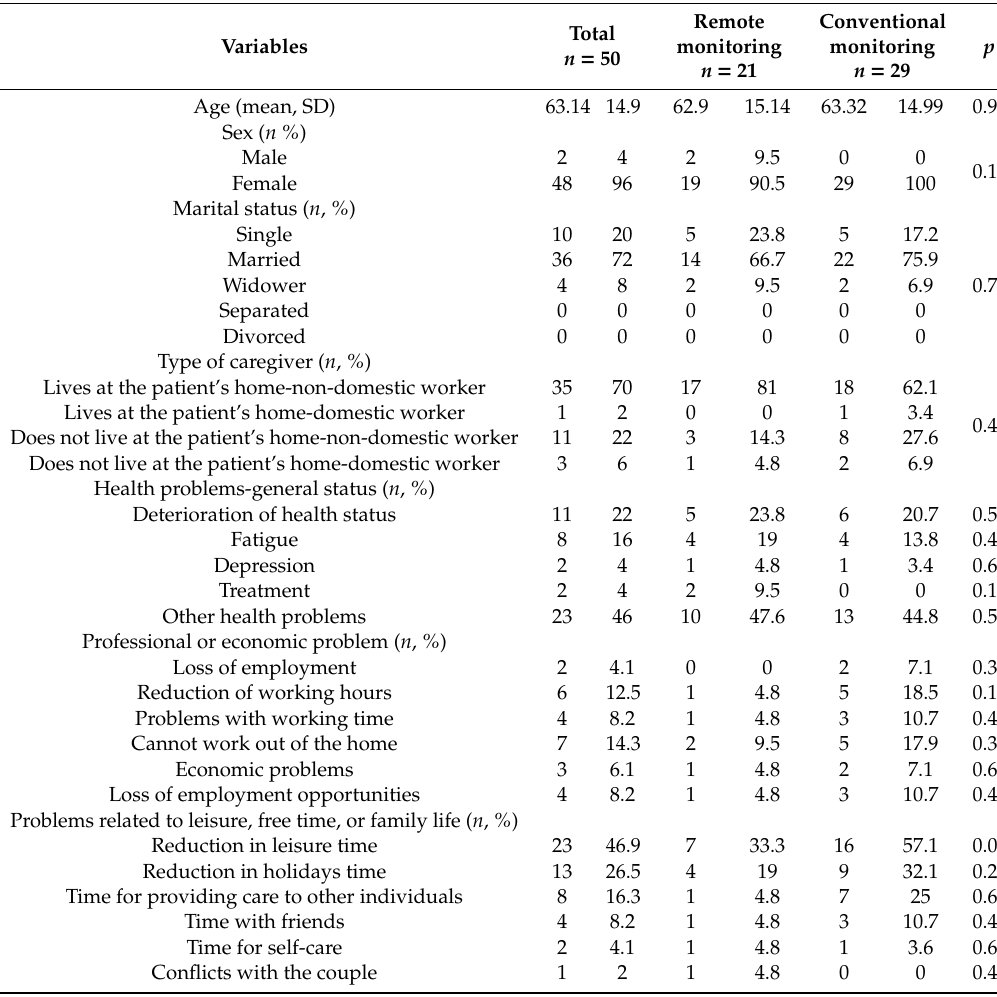
Table 1. Characteristics and problems associated with informal care provided to patients with pacemakers, according to the total number of participants and those in the monitoring